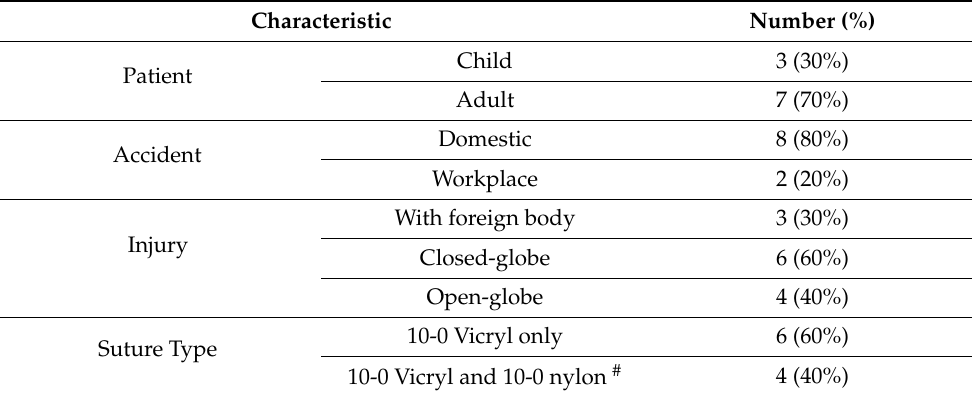
Table 1. Demographic data and preoperative characteristics of eyes ( n = 10). Characteristic Number (%) Child 3 (30%) Patient Adult 7 (70%) Domestic 8 (80%) Accident Workplace 2 (20%) With foreign body 3 (30%) Injury Closed-globe 6 (60%) Open-globe 4